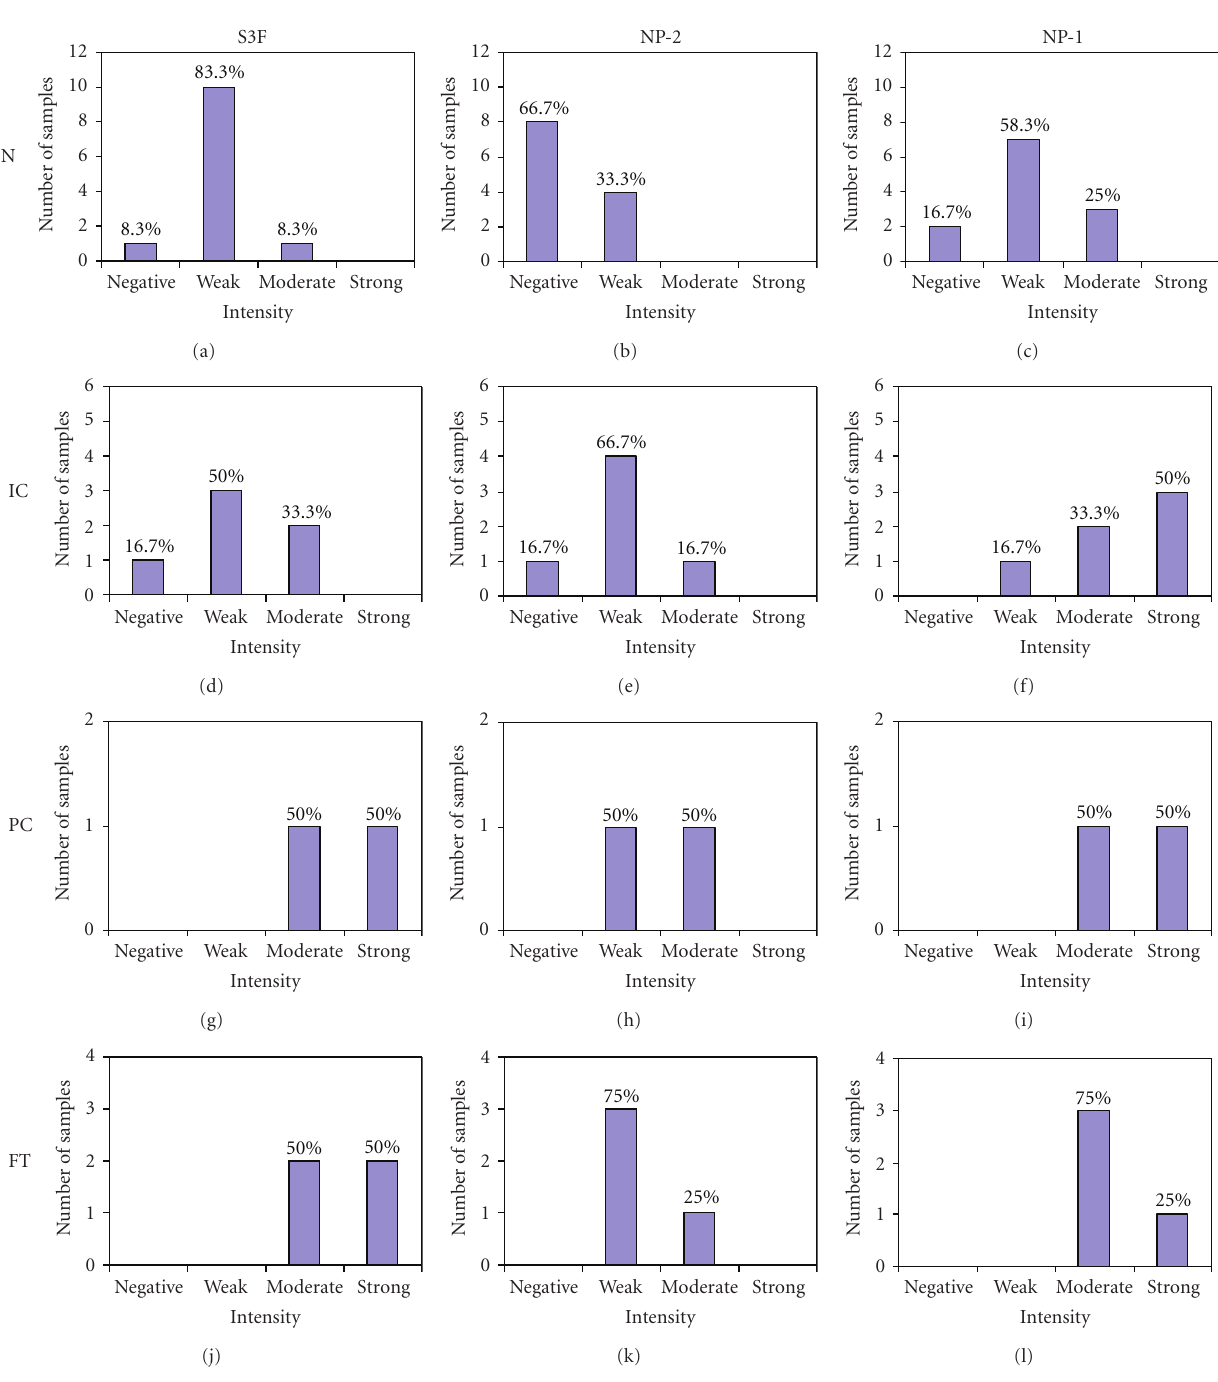
Figure 5: Graphical depiction of S3F, NP-2, and NP-1 expression in inclusion cysts, paraovarian cysts, and fallopian tubes compared to normal ovaries. Immunohistochemically stained sections of normal ovary (N), inclusion cysts (IC), paraovarian cysts (PC) and fallopian tubes (FT) were evaluated for staining intensity and designated as negative, weak, moderate, or strong following staining with antibodies directed against S3F, NP-2, and